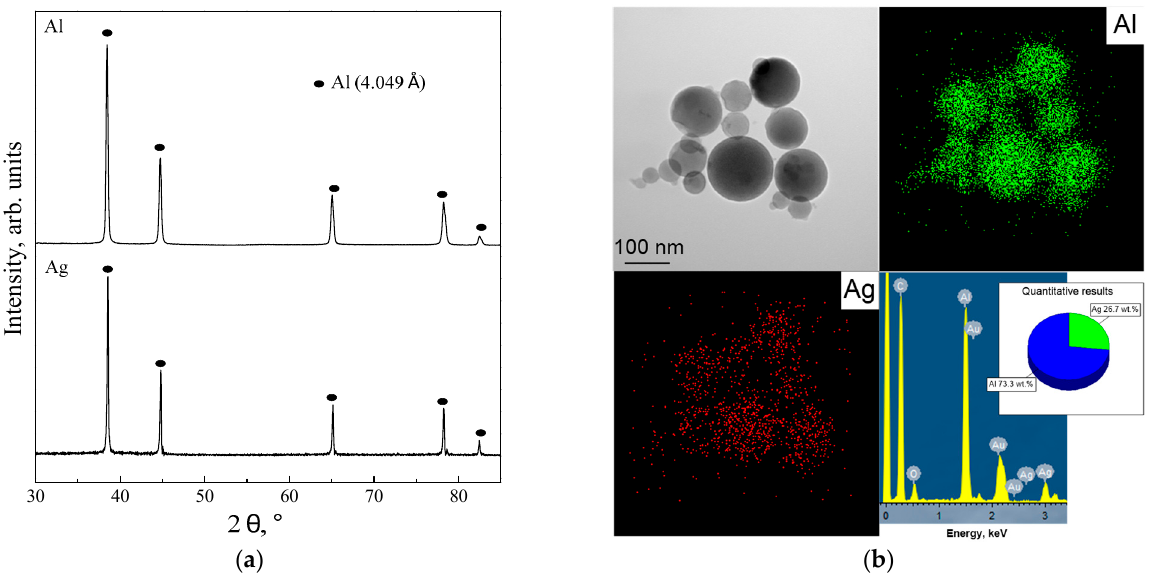
Figure 2. Diffraction pattern of Al and Al/Ag nanoparticles ( a ) and TEM-EDS and elemental distribution maps of Al/Ag nanoparticles ( b ).